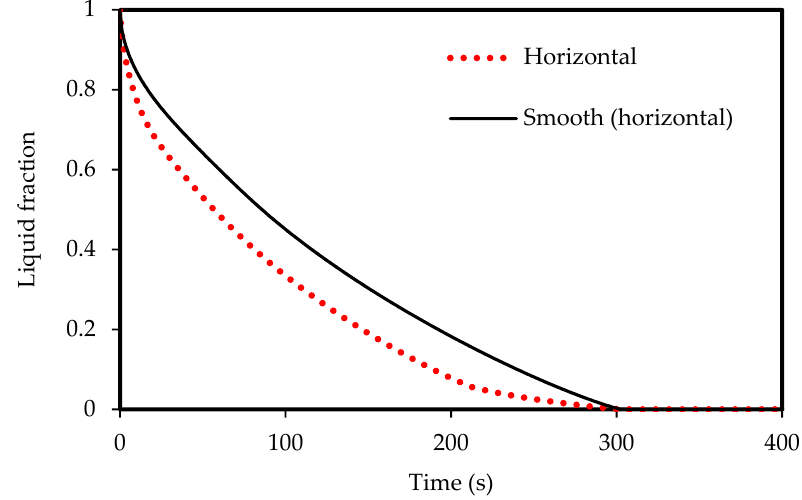
Figure 7. Liquid-fraction evolution during solidification in the horizontal corrugated channel and smooth horizontal channel.